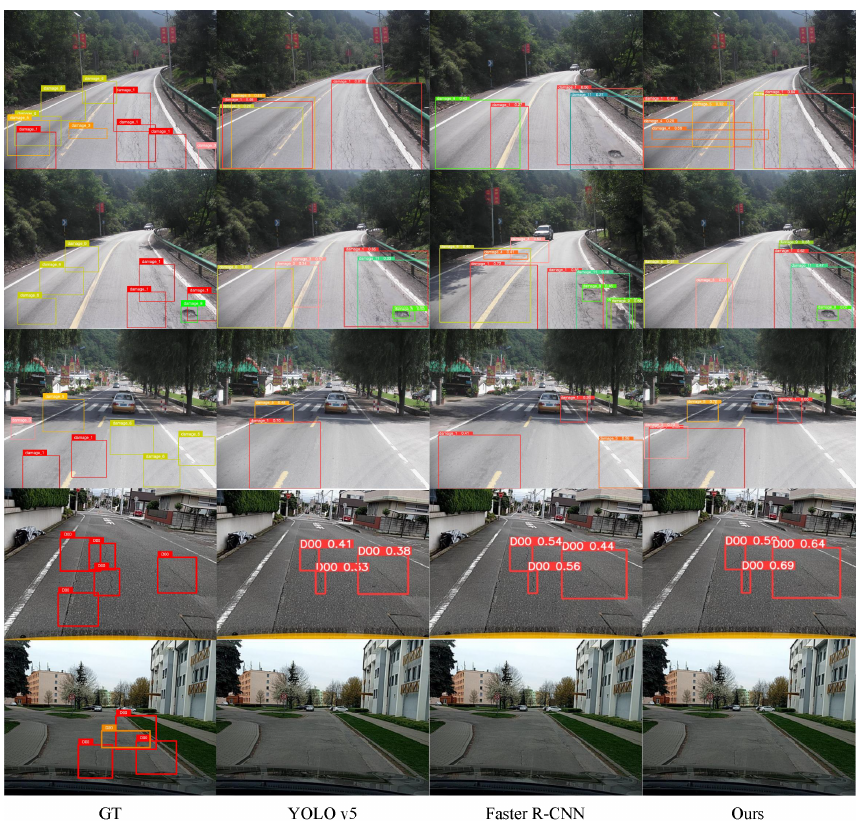
Figure 7. Visual comparative analysis of RDD2020 and CNRDD datasets. The first two samples are from the RDD2020 dataset, and the last three images are from the CNRDD